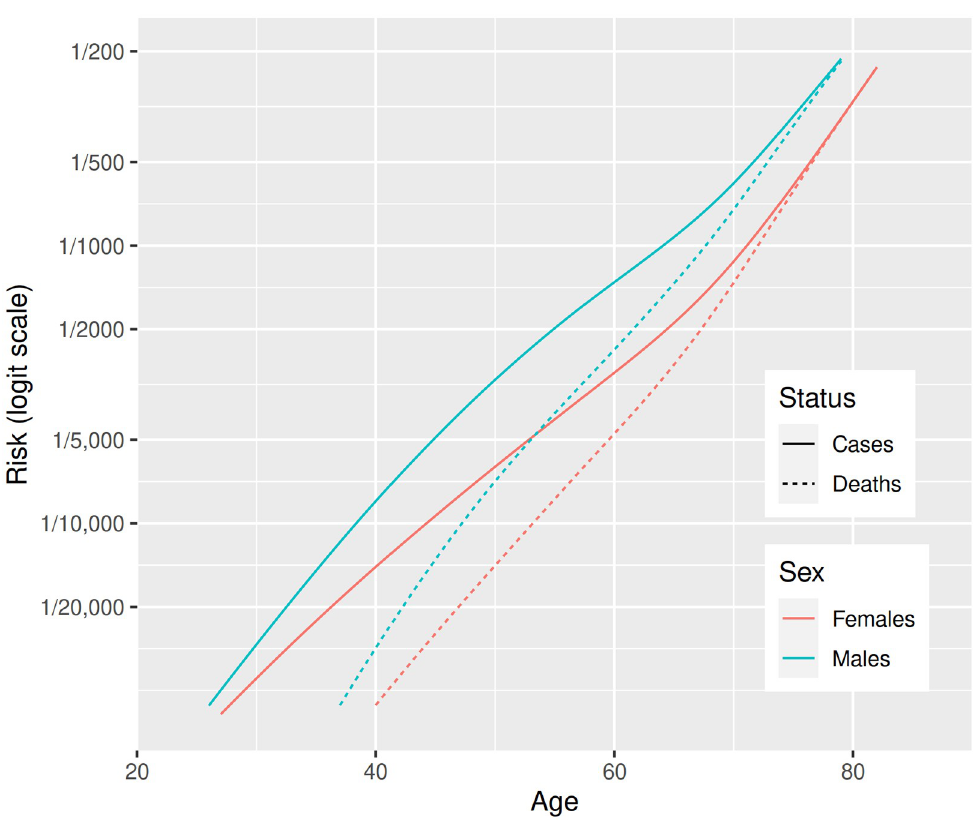
Fig 1. Incidence of severe and fatal COVID-19 in Scotland by age and sex: Generalized additive models fitted to severe and fatal cases for males and females separately. COVID-19, coronavirus disease 2019.